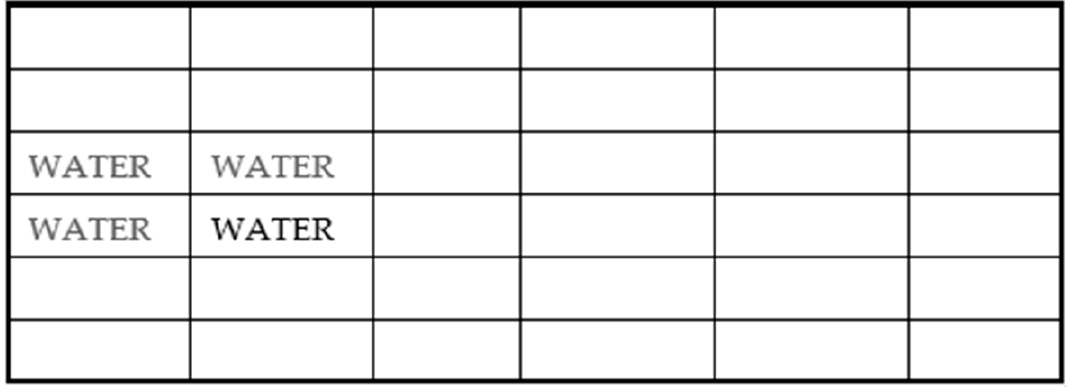
Figure 10. Retrieve the starting WNM’ <x> and apply the difference WNM’ <B> to it yielding WNM t ’ <x+B> (Equation